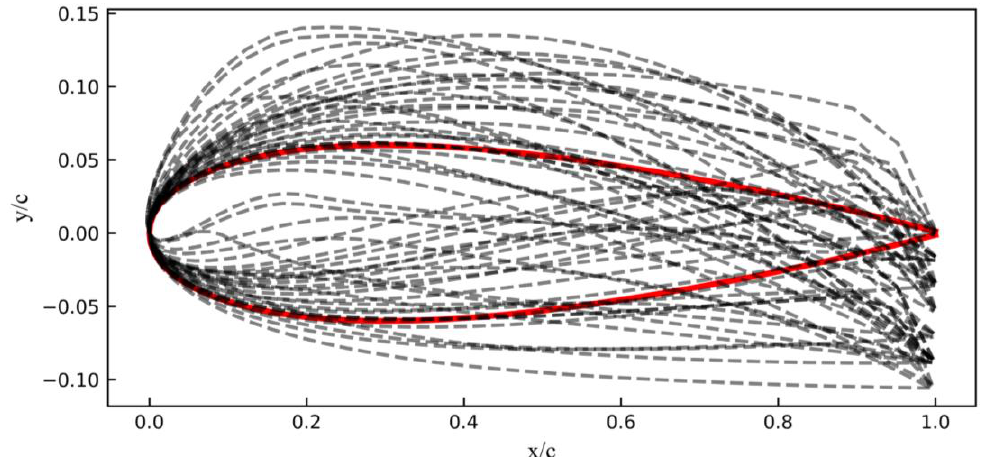
Figure 8. The geometry of 30 airfoils sampled from the airfoil library (NACA0012 highlighted by the solid red line).